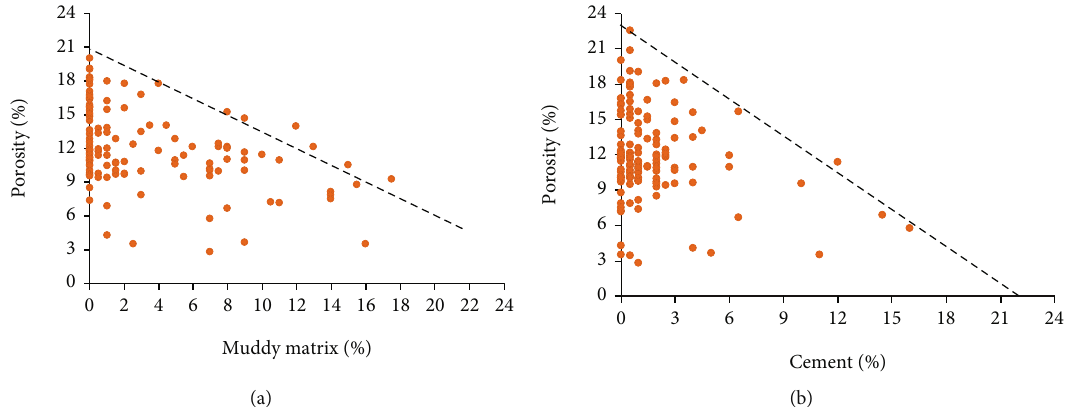
Figure 16: In fl uence of muddy matrix and cement on the measured porosity. (a) The porosity versus the muddy matrix content. (b) The porosity versus the cement